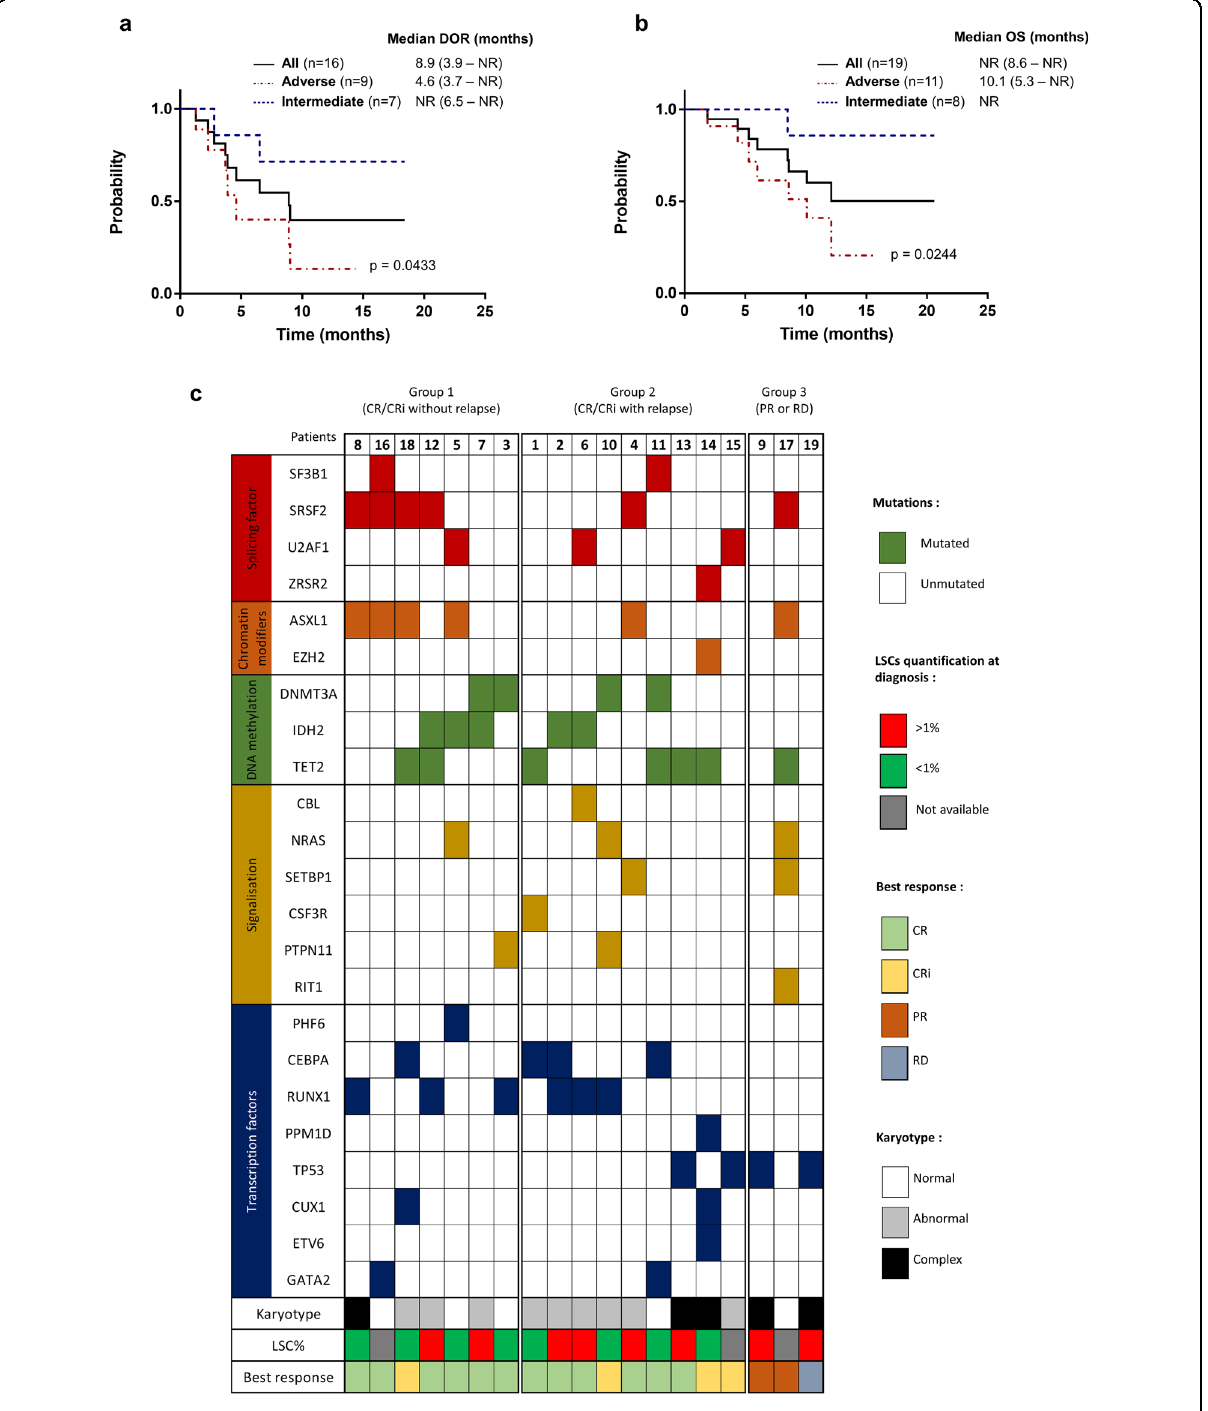
Fig. 1 Outcome for patients treated by venetoclax combination therapy. a Median response duration for all patients who achieved CR/CRi and according to their adverse (red line) or intermediate (blue line) cytogenetic risk. b Overall survival for the entire patient cohort and according to their adverse (red line) or intermediate (blue line) cytogenetic risk. c Patients were categorized into those who achieved CR/CRi without relapse (group 1; n = 7) or with relapse at any time during the study (group 2; n = 9) and patients who only achieved partial remission (PR) or with a refractory disease (RD) (group 3; n = 3). The presence of study ID number, indicated mutations, complex karyotype, percentage of LSCs among the total blast population and best response are shown for each